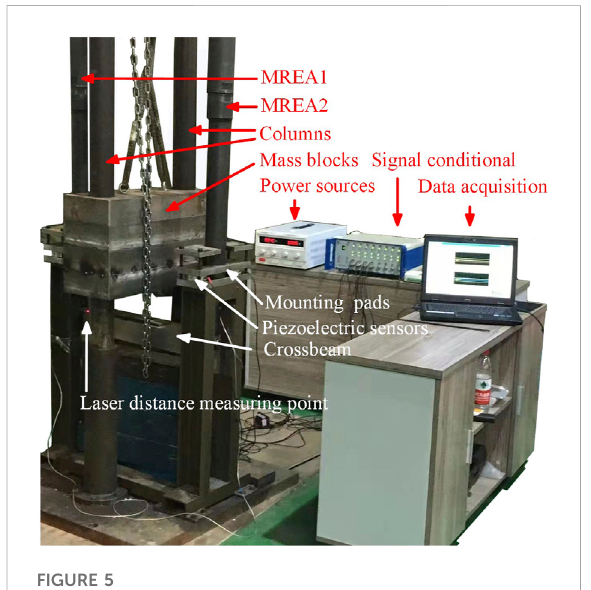
FIGURE 5 Experiments based on the drop test bench.